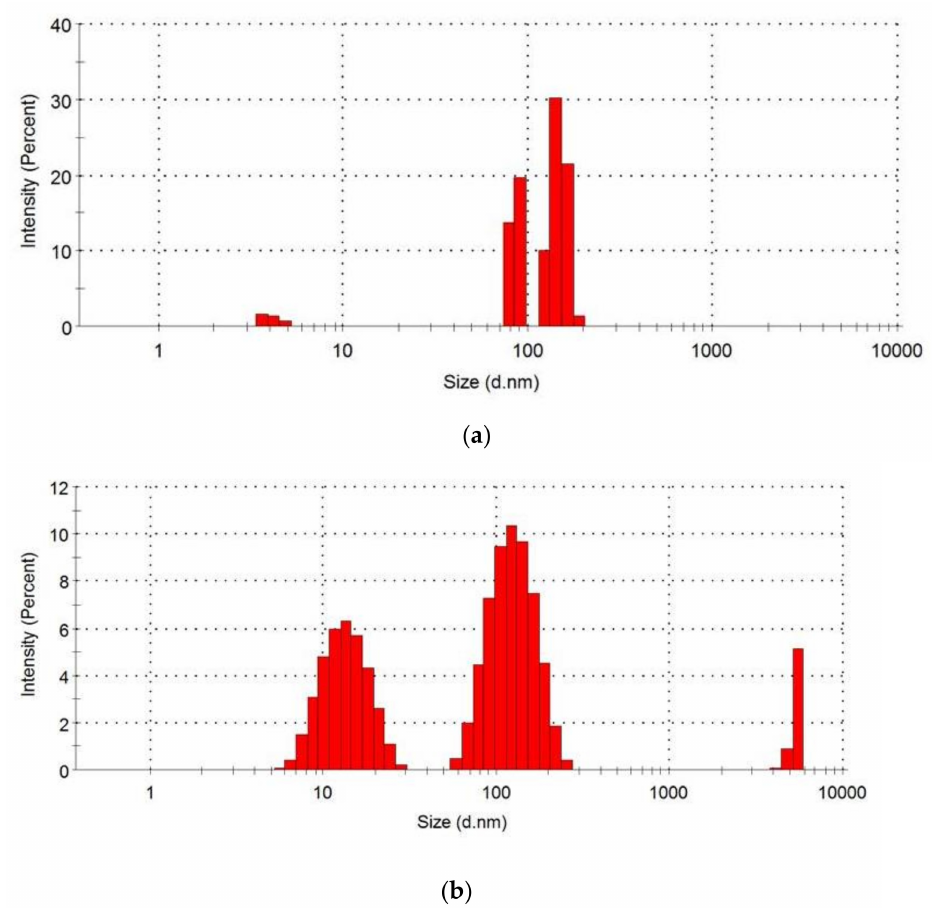
Figure 2. Particle size distribution of ( a ) unloaded PC101-based nanoparticles; ( b ) PC101-based insulin